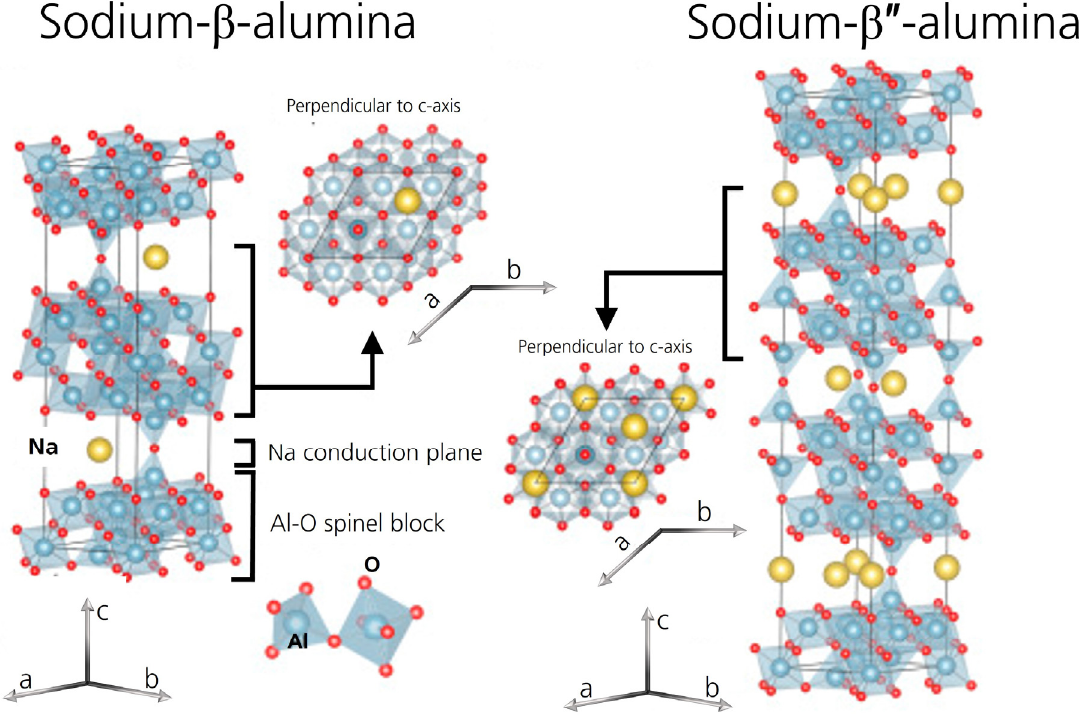
Figure 1. Crystal structures of sodium- β -alumina and sodium- β″ -alumina. Adapted from [18], Copyright (2017), with permission from Elsevier.